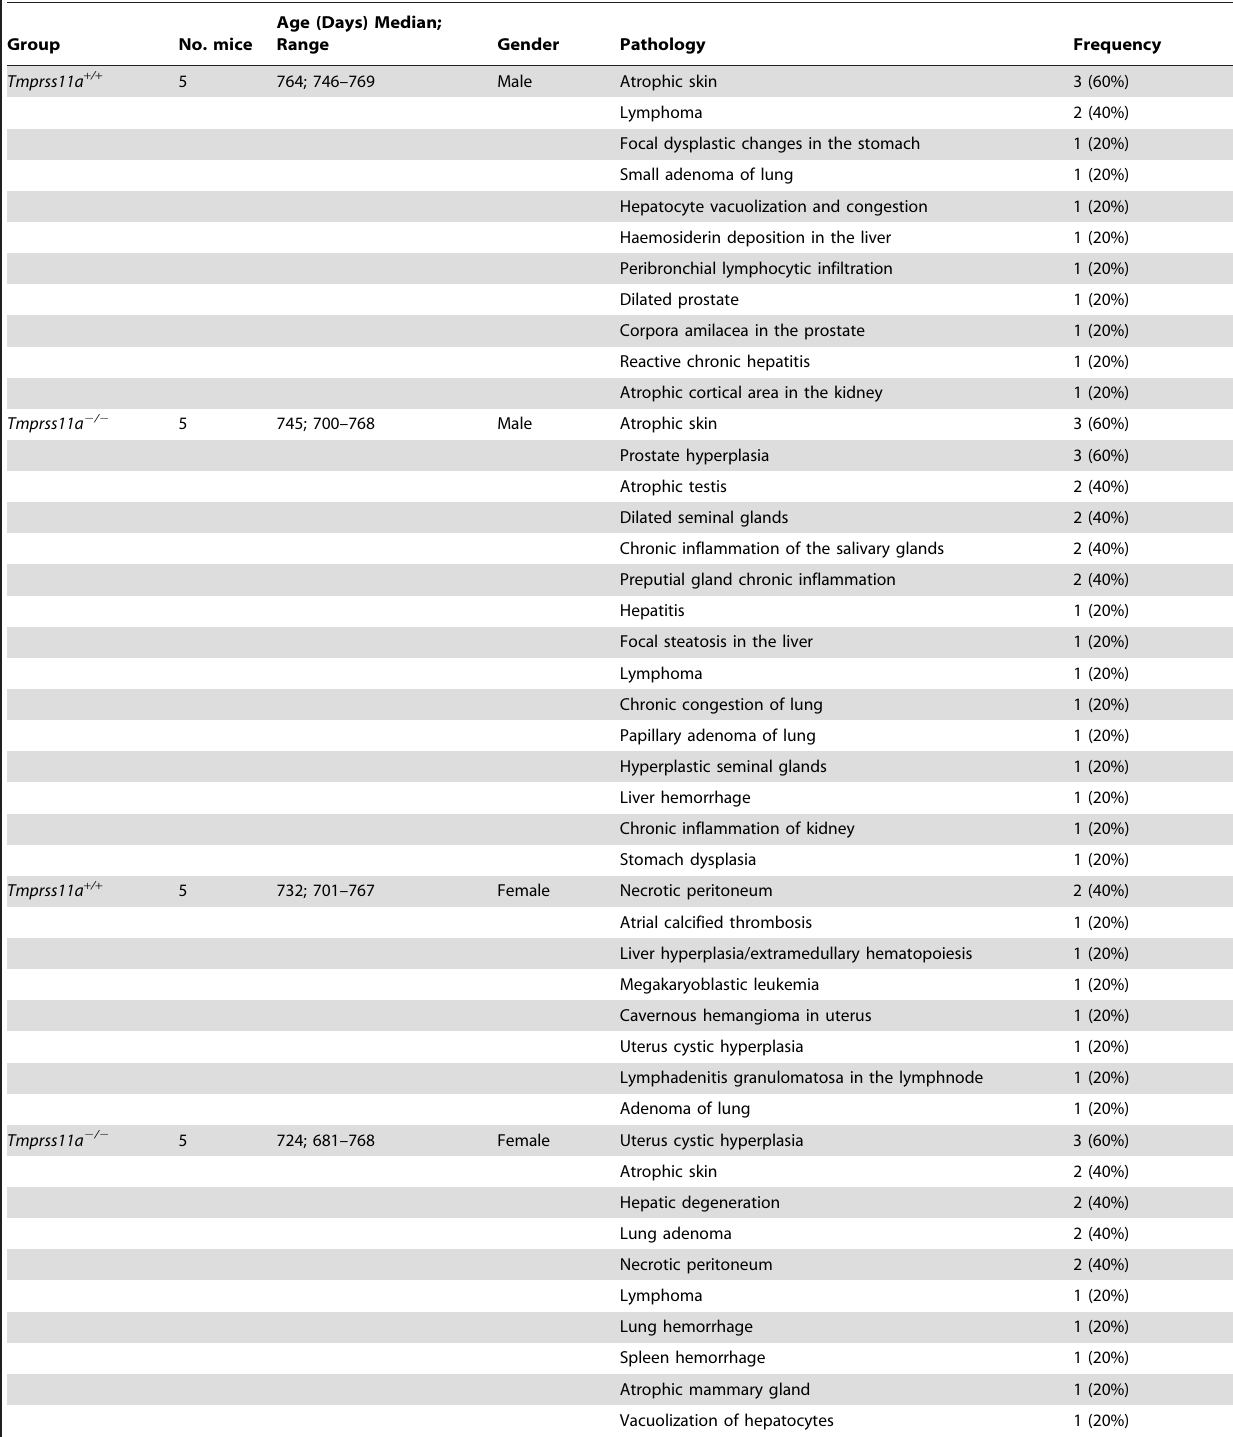
Table 3. Pathological findings in tissues from aging TMPRSS11A-deficient mice.